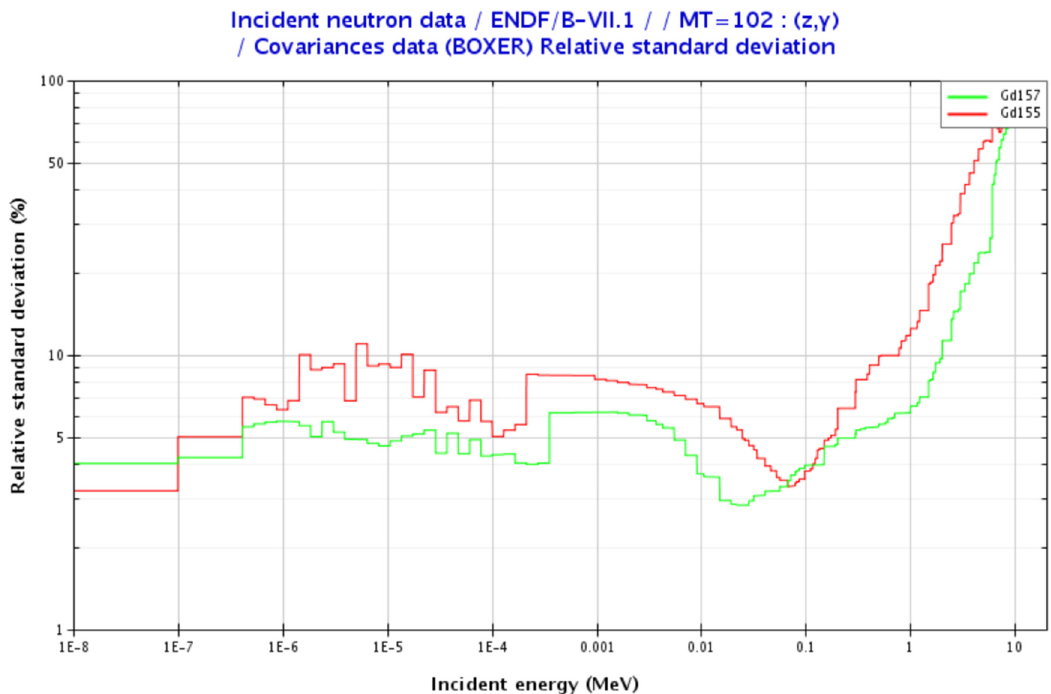
Fig. 1. Relative standard deviation of 155 Gd and 157 Gd capture cross